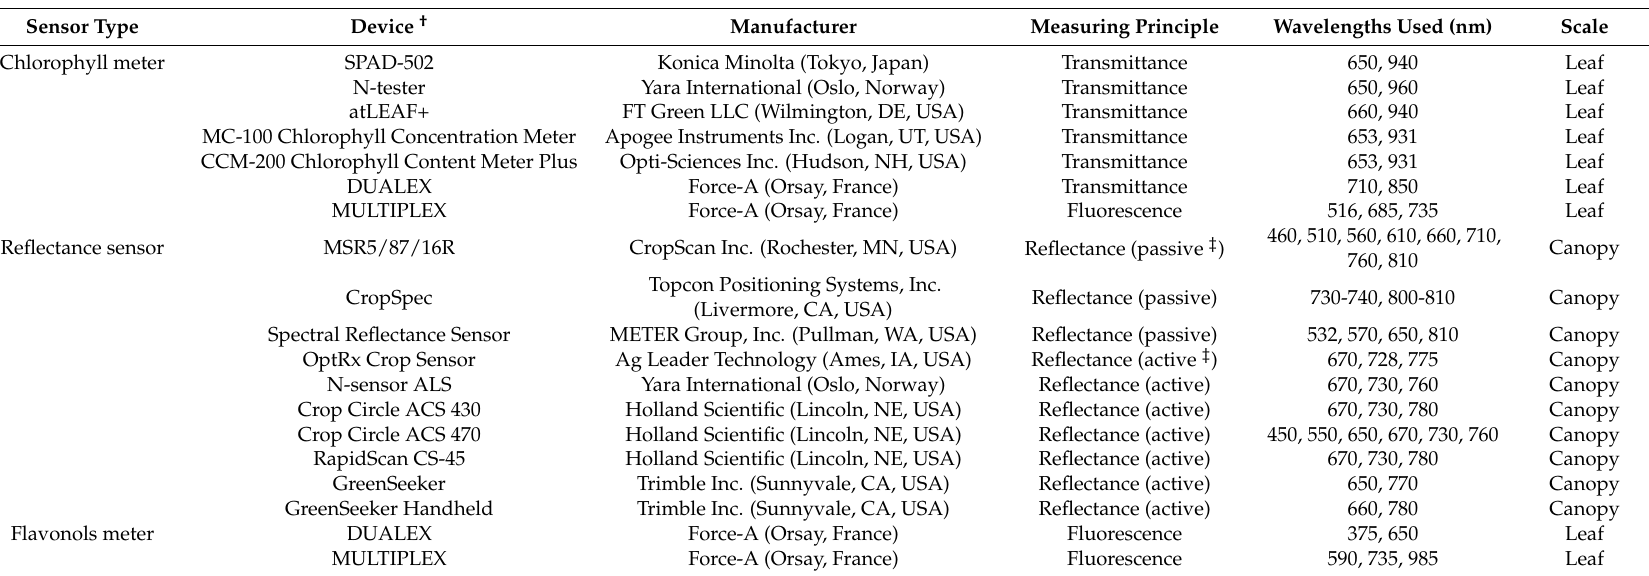
Table 1. Characteristics of some proximal optical sensors with potential for use for nitrogen (N) management of vegetable